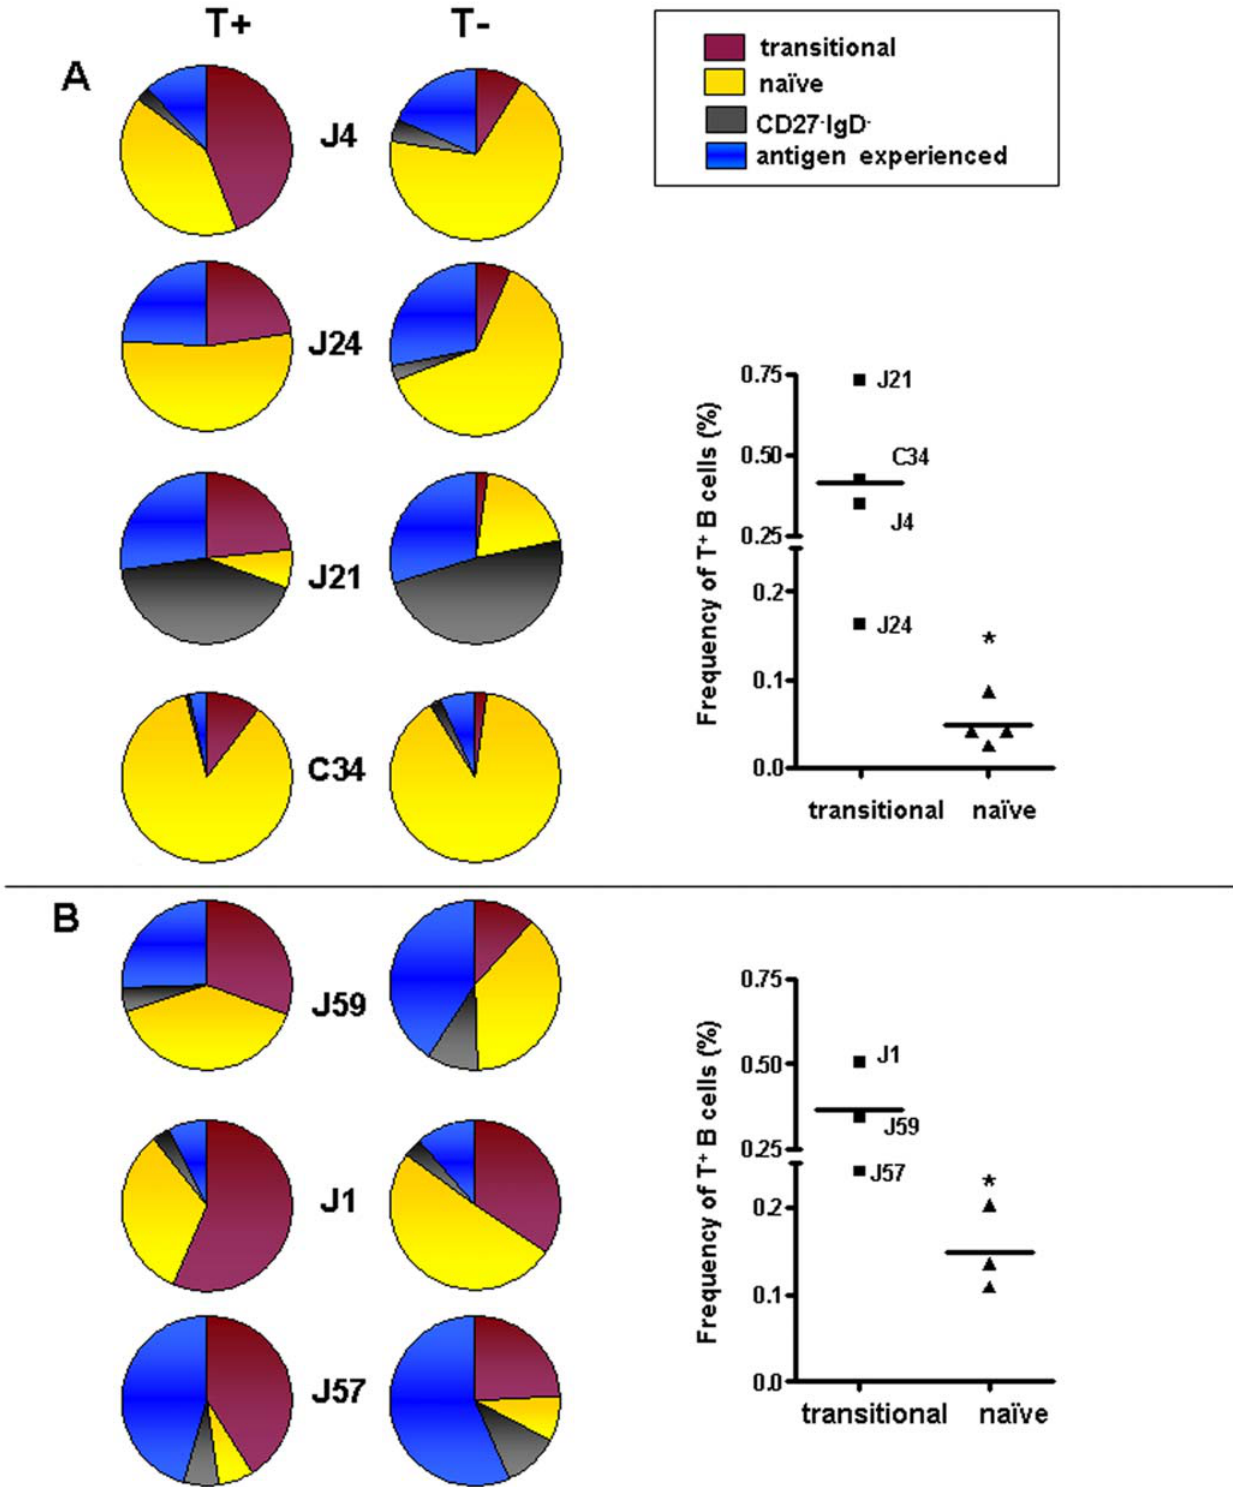
Figure 5. Early checkpoints of B cell tolerance. Phenotype of tetramer-binding B cells in 7 patients with SLE in patients with quiescent disease, defined as a SLEDAI # 4 ( A ) or patients showing signs of clinical disease activity, defined as a SLEDAI . 4 ( B ). The percentage of tetramer-binding and tetramer-negative B cells with a transitional phenotype (bordeaux) and the calculated percentage of tetramer-binding (T + ) and tetramer-negative (T-) B cells with a naı¨ve phenotype (yellow) in 7 patients with SLE. The percentage of naı¨ve B cells was calculated by subtracting the percentage of CD27 2 CD10 + B cells from the percentage of CD27 2 IgD + B cells. The percentage of tetramer-binding and tetramer-negative B cells with an antigen- experienced phenotype comprising CD27 + switched (IgD 2 ) and non-switched (IgD + ) memory B cells and CD19 low CD27 ++ plasmablasts is shown in blue. CD27 2 IgD 2 B cells (grey) were excluded from analysis. The right panel of the figure shows the frequencies of tetramer-binding B cells within the transitional and naı¨ve B cell subsets in these lupus patients. Mean values are shown. *Patients with moderately active disease exhibited a significantly higher frequency of tetramer-binding B cells in the naı¨ve population (p , 0.02, unpaired t test). doi:10.1371/journal.pone.0005776.g005 PLoS ONE |